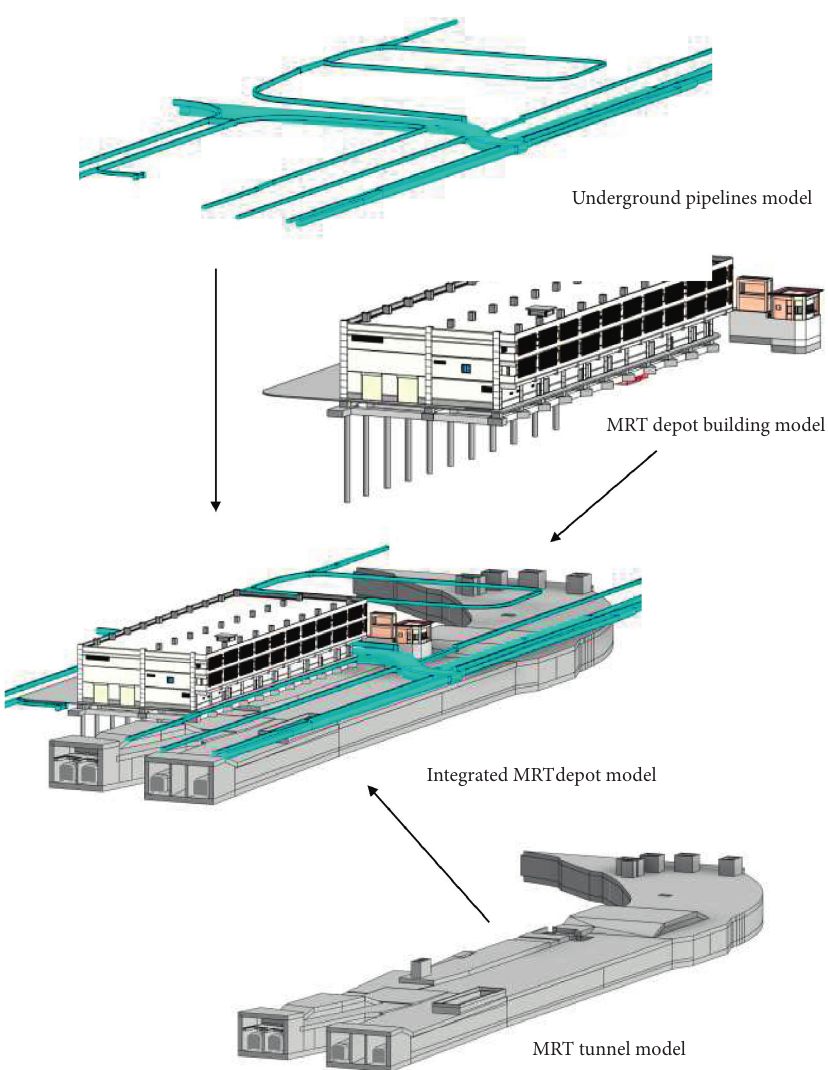
Figure 6: The integrated BIM model of the CBMDM